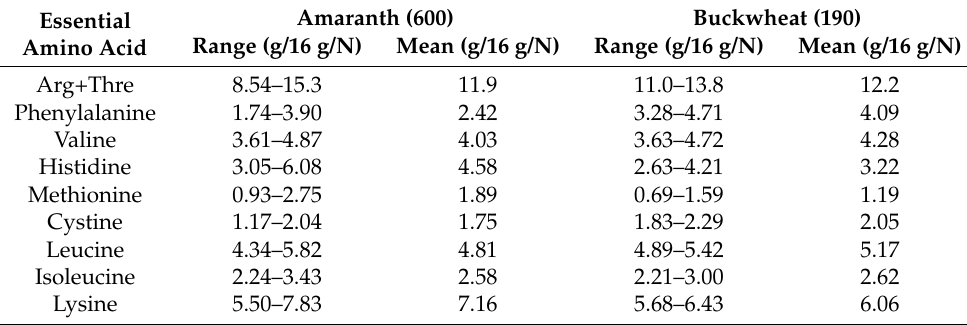
Table 5. Prediction values of amaranth and buckwheat for essential amino acids to check the applicability of the developed